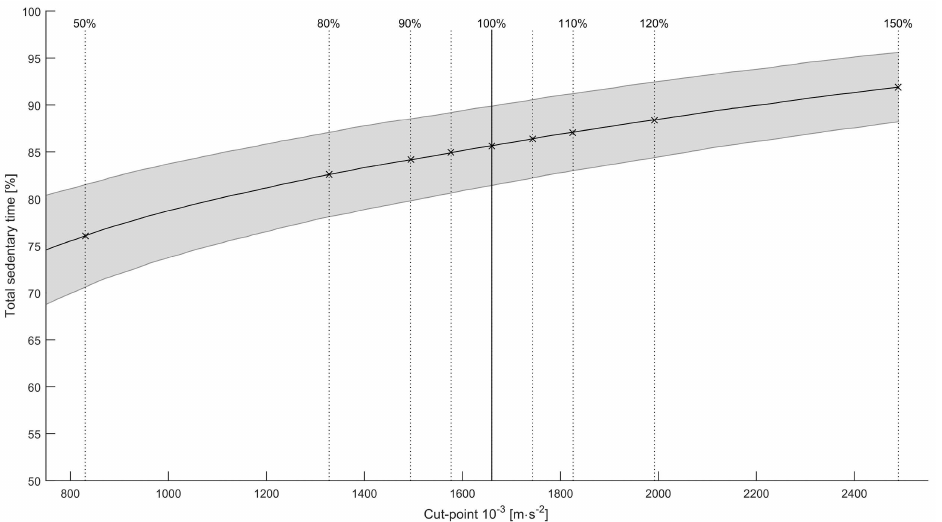
Figure 3. Mean total sedentary time as percentage of wear time for various cut-points. The shaded area is the standard deviation. Vertical lines indicate the various thresholds, with the solid line being the optimal